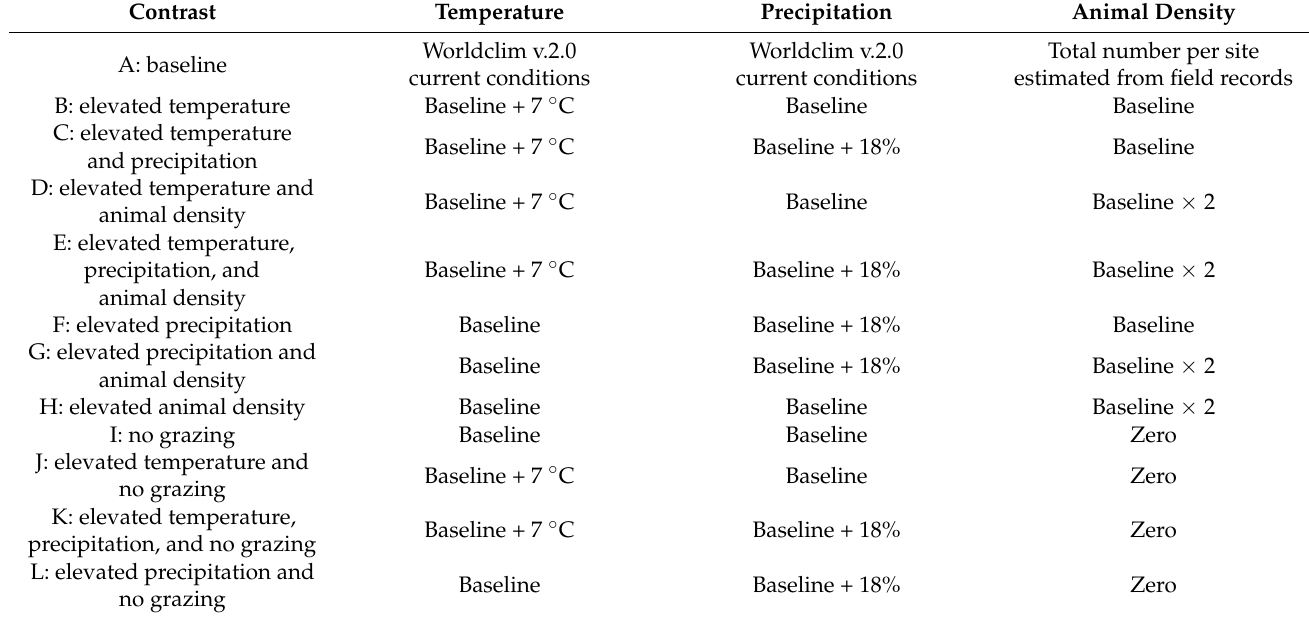
Table 1. Fixed-level contrasts explored with the Rangeland Production Model (RPM) at 15 sites spanning a rainfall